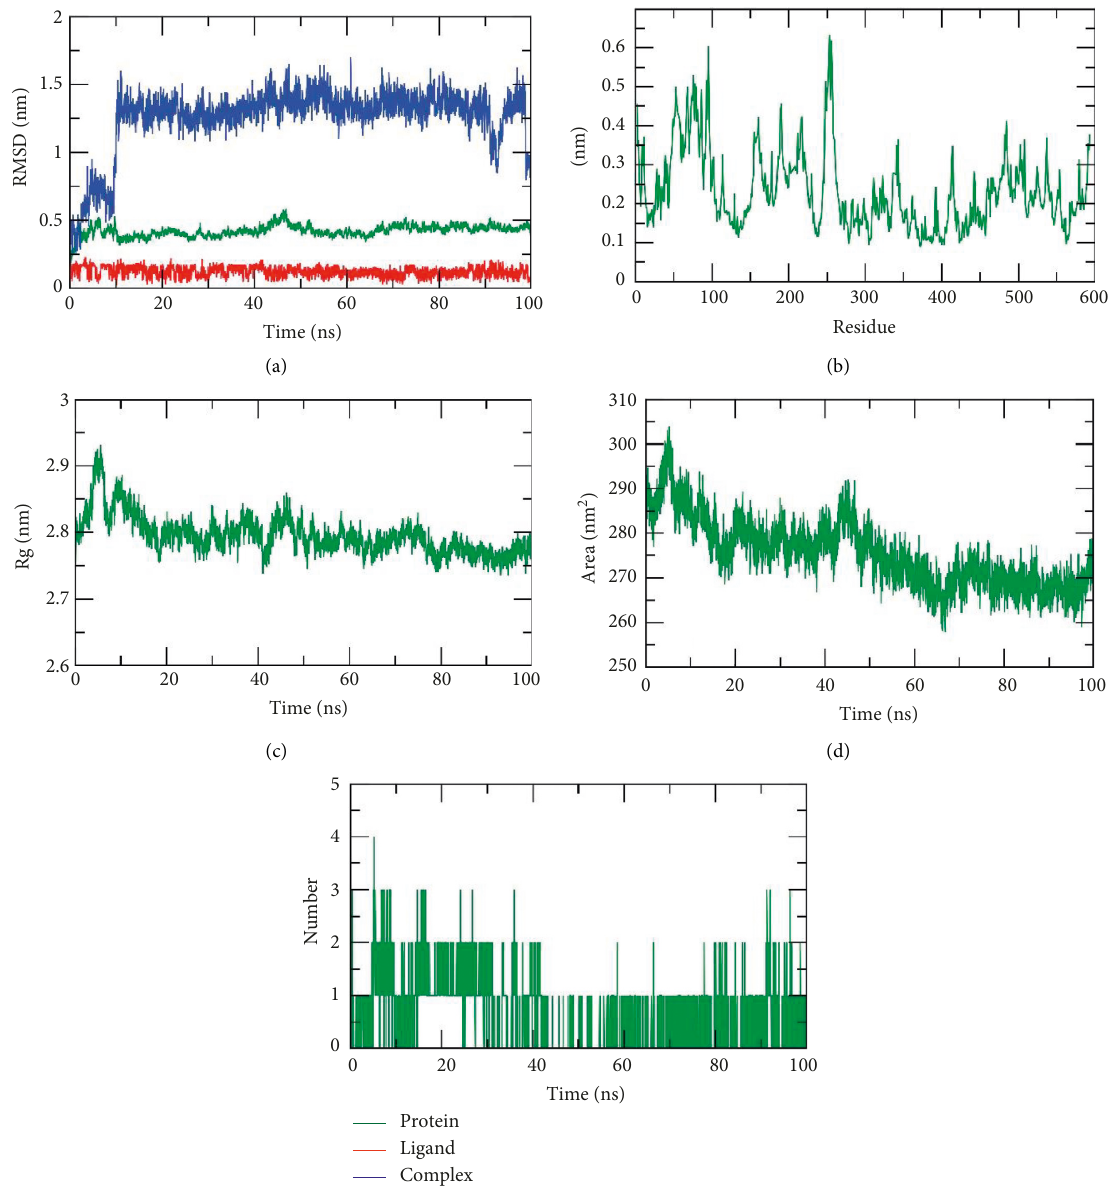
Figure 12: M D simulation results: (a) RMSD values of SARS-CoV-2 helicase, 533, and SARS-CoV-2 helicase- 533 complex; (b) RMSF for SARS-CoV-2 helicase; (c) R g of SARS-CoV-2 helicase; (d) SASA of SARS-CoV-2 helicase; and (e) H-bonding between SARS-CoV-2 helicase- 533 complex in the MD